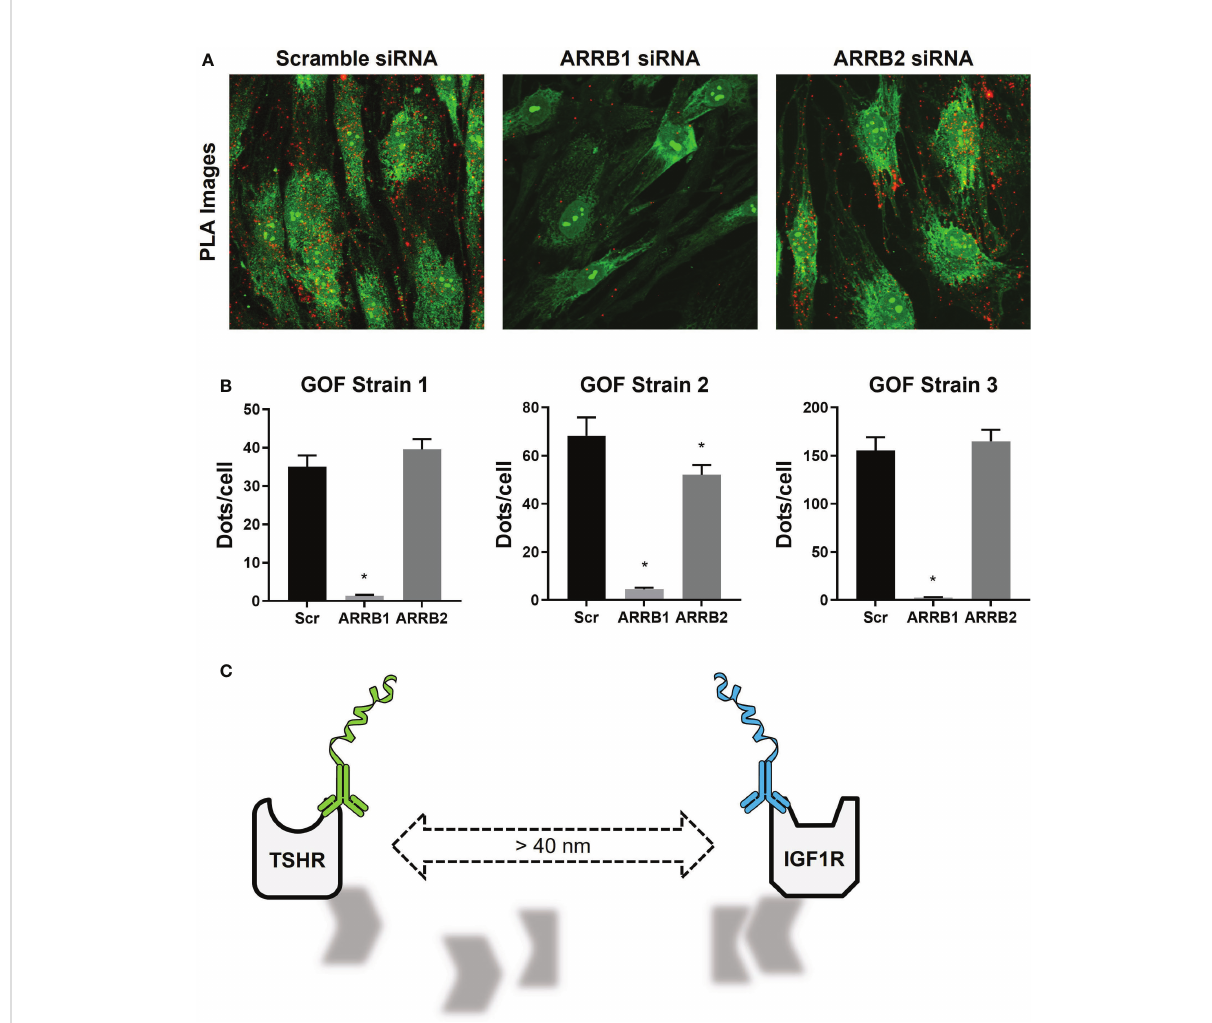
FIGURE 3 TSHR/IGF1R Signalosomes in Human Graves ’ Orbital Fibroblasts. (A) Duolink PLUS and MINUS probes were conjugated to TSHR antibody KSAb1 and IGF1R antibody a IR3, respectively. TSHR/IGF1R proximity was shown in fi xed GOFs treated with Scramble, b -arrestin 1 (ARRB1), or b -arrestin 2 (ARRB2) siRNA. Duolink signals are shown in red. Nuclear and cell staining with SYTO-9 is shown in green. (B) Quanti fi cation of positive PLA signals (Dots) per cell are shown for three GOF strains. ARRB1 siRNA signi fi cantly reduced the number of positive PLA signals in all strains, whereas reduction by ARRB2 siRNA was only signi fi cant in one. *indicates P < 0.05. (C) In the absence of b -arrestin 1, the signalosome dissociates, increasing the distance between TSHR and IGF1R to greater than 40 nm, leading to a loss of PLA signals. Panels (A, B) were adapted with permission from Krieger et al.